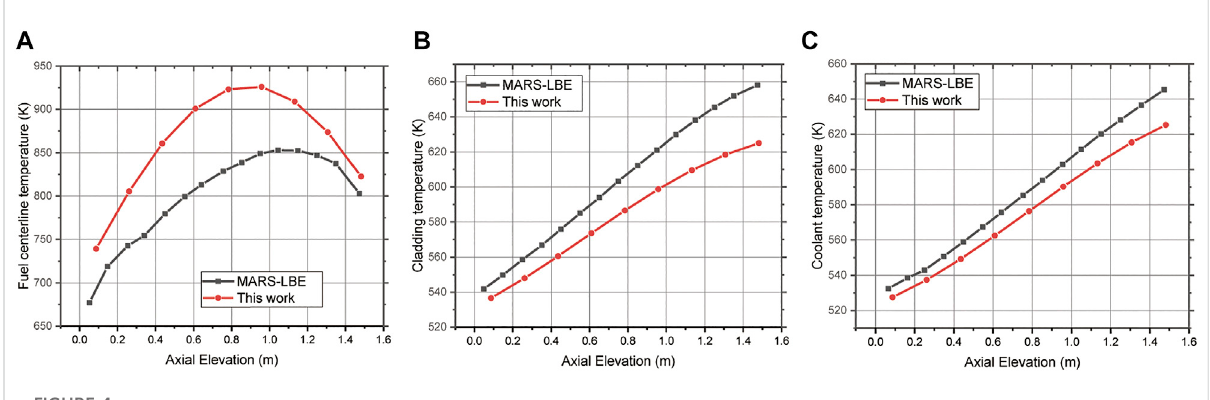
FIGURE 4 MARS-LBE code comparison results of (A) Fuel centerline temperature (B) Cladding average temperature (C) Coolant temperature.